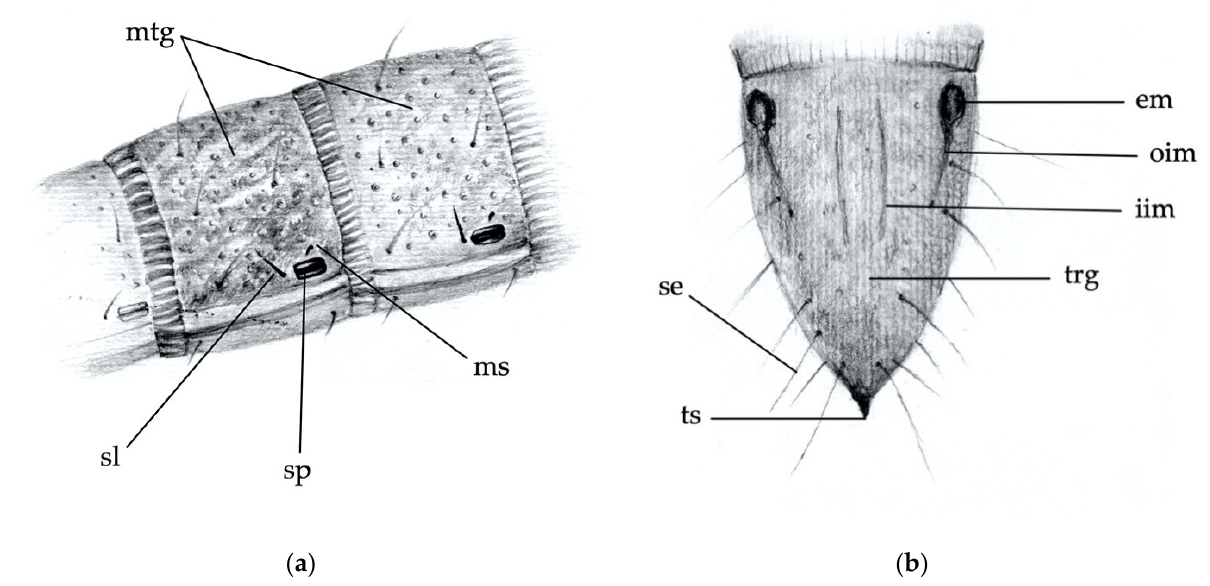
Figure 3. Main body parts distinguishing larvae of the different species. ( a ) Abdominal segments (dorso-lateral view): mtg, mediotergite with granulation and roughness; ms, minus seta ; sl, large seta; sp, spiracle. ( b ) Ninth abdominal segment (dorsal view): em, “eye-like” impression; iim, inner longitudinal line; oim, outer longitudinal line; se, seta; trg, tergum; ts, terminal spike.